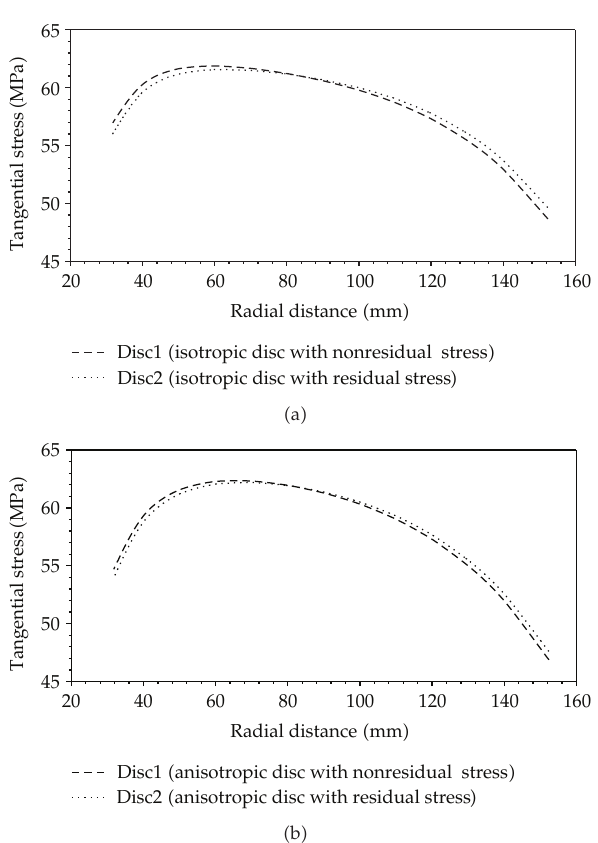
Figure 3: Variation of tangential stress along the radial distance in the isotropic/anisotropic discs rotating with an angular velocity 15000rpm at